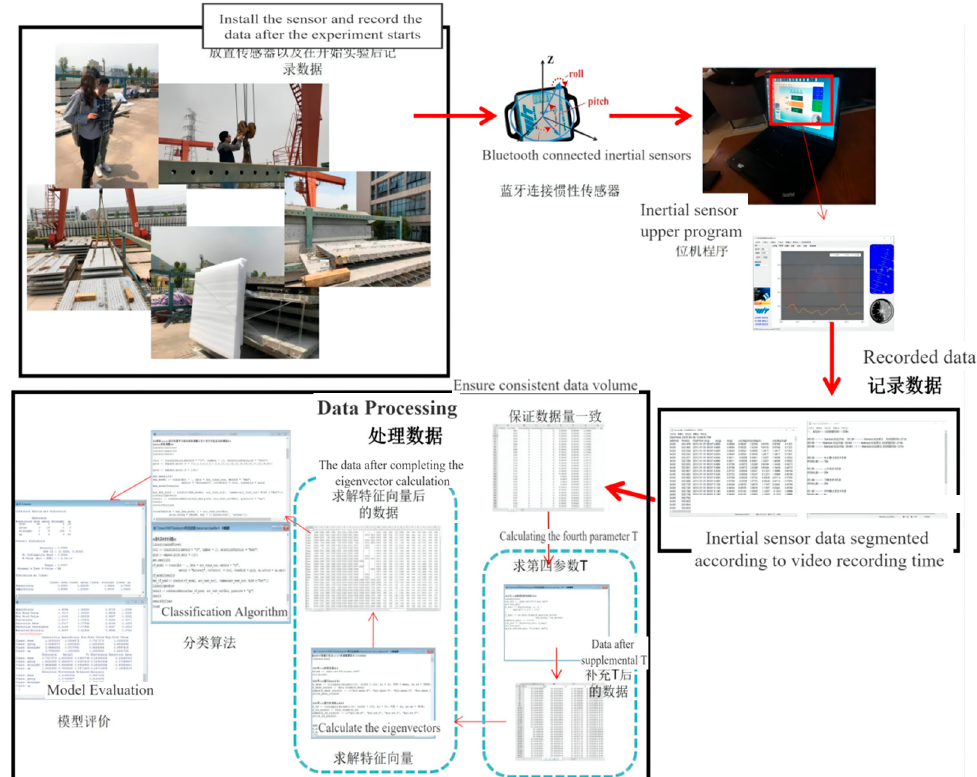
Figure 8. IMU standard operation process for detecting the collision of prefabricated building com- ponents.